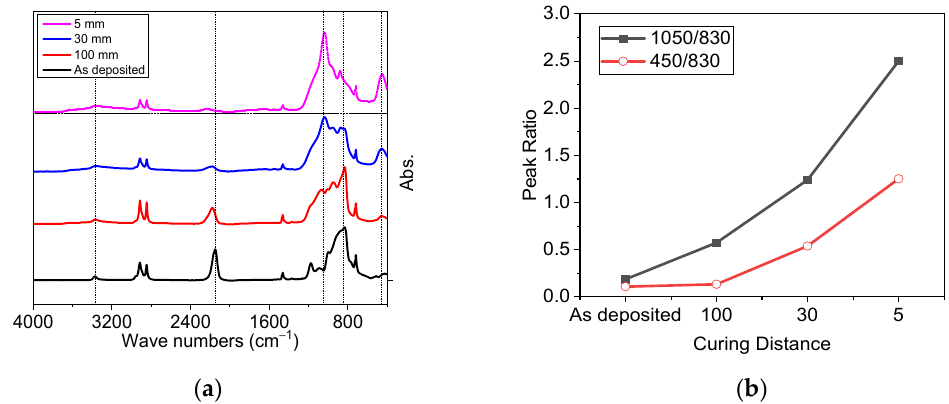
Figure 4. FTIR spectra of PHPS and corresponding peak ratios. ( a ) FTIR spectra of PHPS cured with different curing distances, ( b ) peak ratios of peak where black curve with closed squares represents peak ratio of I (1050 cm − 1 )/ I (830 cm − 1 ) and red curve with open circle represents I (450 cm − 1 )/ I (830 cm − 1 ) peak intensity.